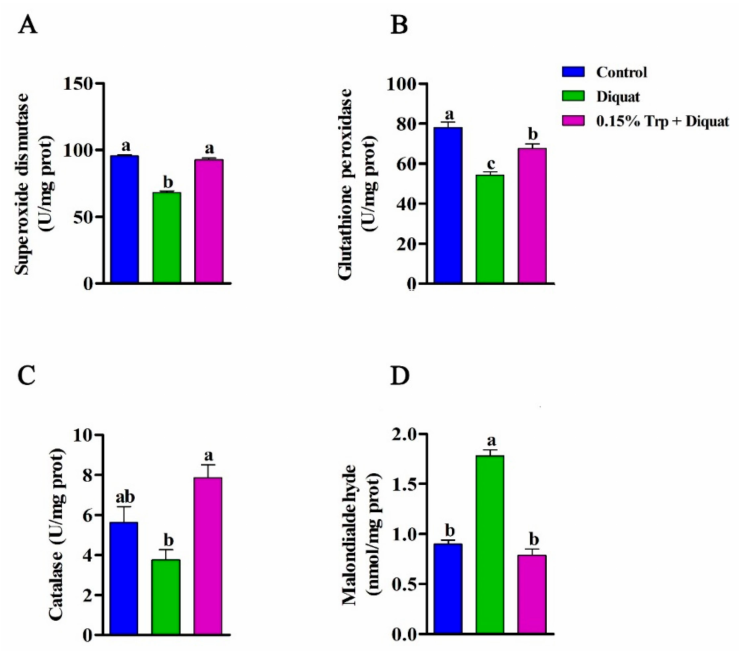
Figure 4. E ff ects of dietary tryptophan supplementation on jejunal redox status of piglets challenged with diquat. ( A ) Superoxide dismutase activity; ( B ) glutathione peroxidase activity; ( C ) catalase activity; ( D ) malondialdehyde concentration. Data are means ± standard error; n = 8 for each group. Mean values sharing di ff erent superscripts within the same row di ff er significantly ( p < 0.05). Control, piglets fed the basal diet without diquat injection; diquat, piglets fed the basal diet and challenged with diquat; 0.15% Trp + diquat, piglets fed the 0.15% supplemented diet and treated with